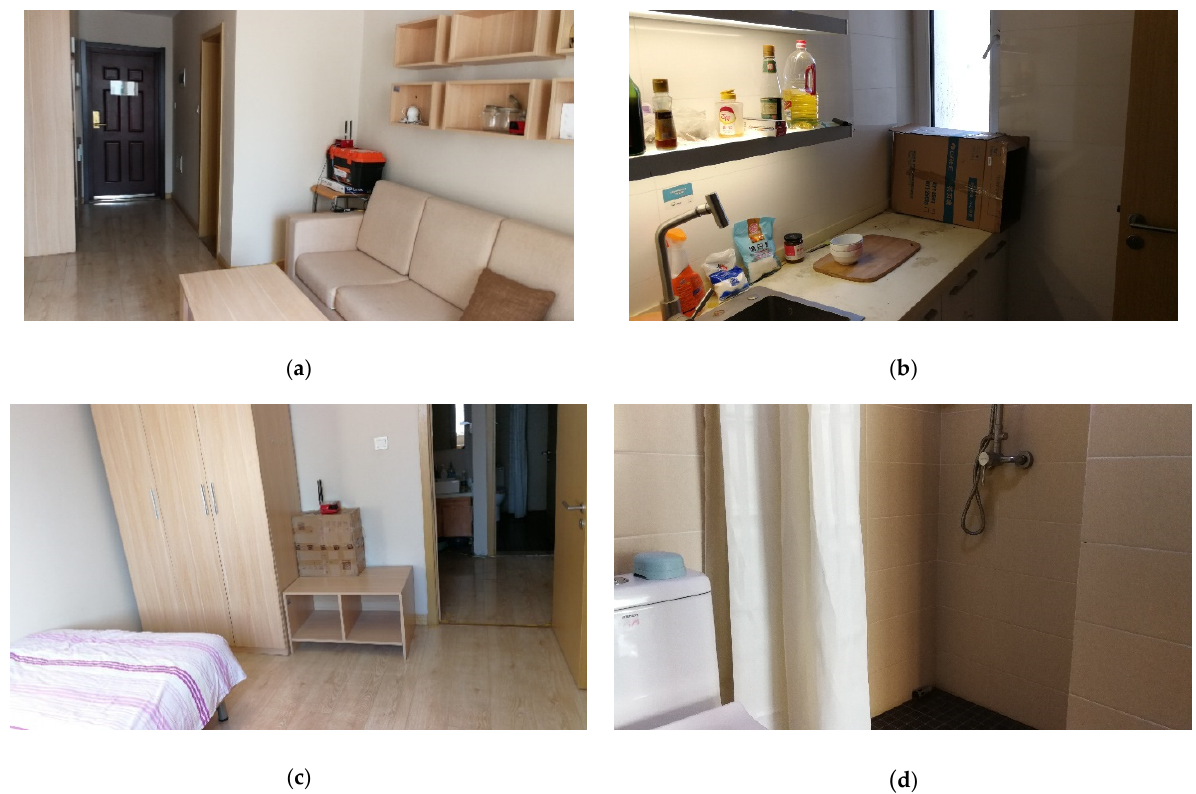
Figure 14. The multi-room smart home environment. ( a ) Living-room; ( b ) Kitchen; ( c ) Bedroom; ( d ) Toilet.